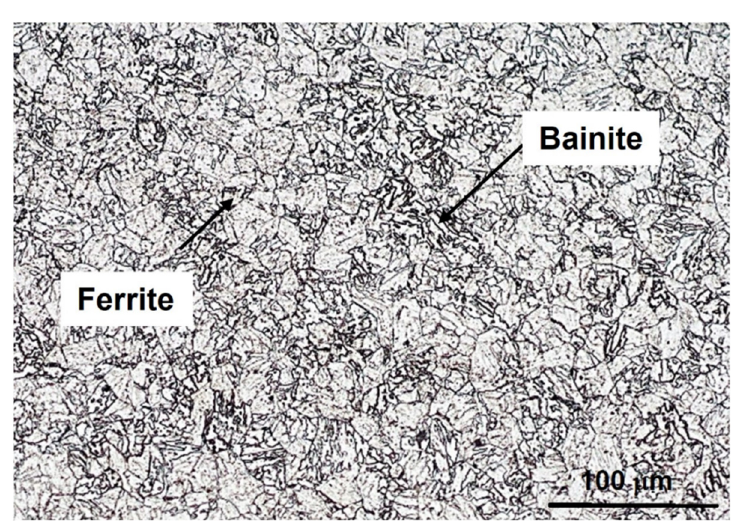
Figure 3. LM micrograph of the as-received steel.